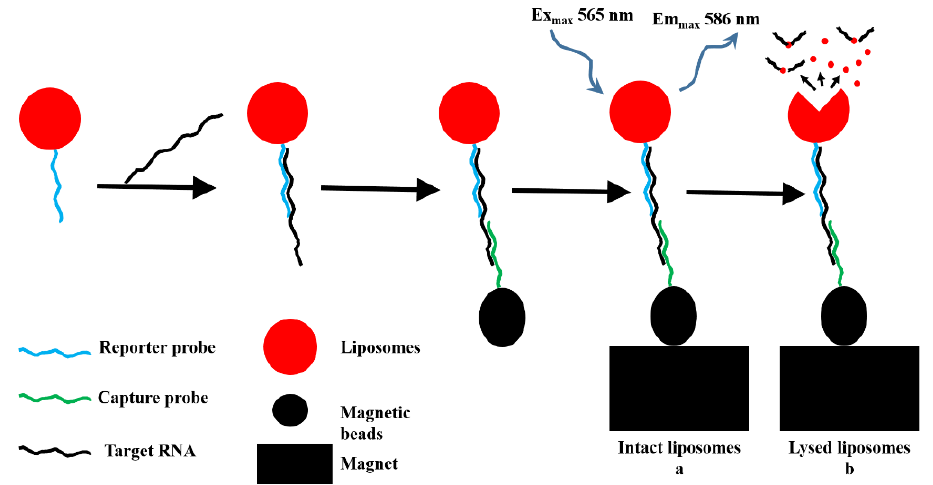
Figure 3. The principle scheme of the biosensor based on DNA/RNA hybridization, magnetic bead complex formation and fluorescence detection of RNA-specific complexes via intact ( a ) and lysed ( b ) liposomes (Retrieved from [77]).